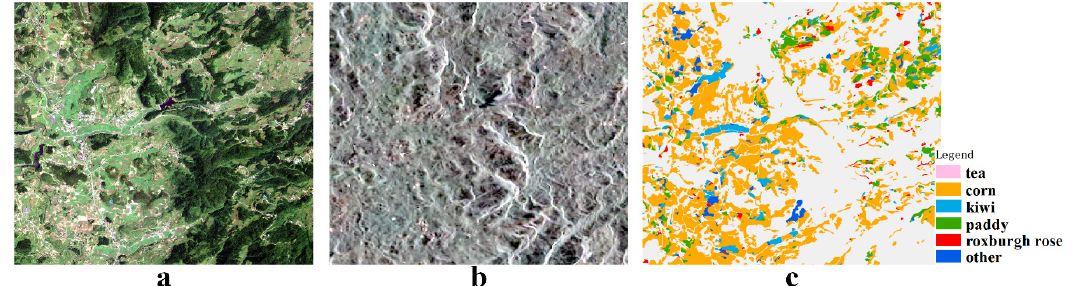
Figure 1. Crop classification based on synthetic aperture radar (SAR): ( a ) optical image; ( b ) SAR image; ( c ) crop planting structure.